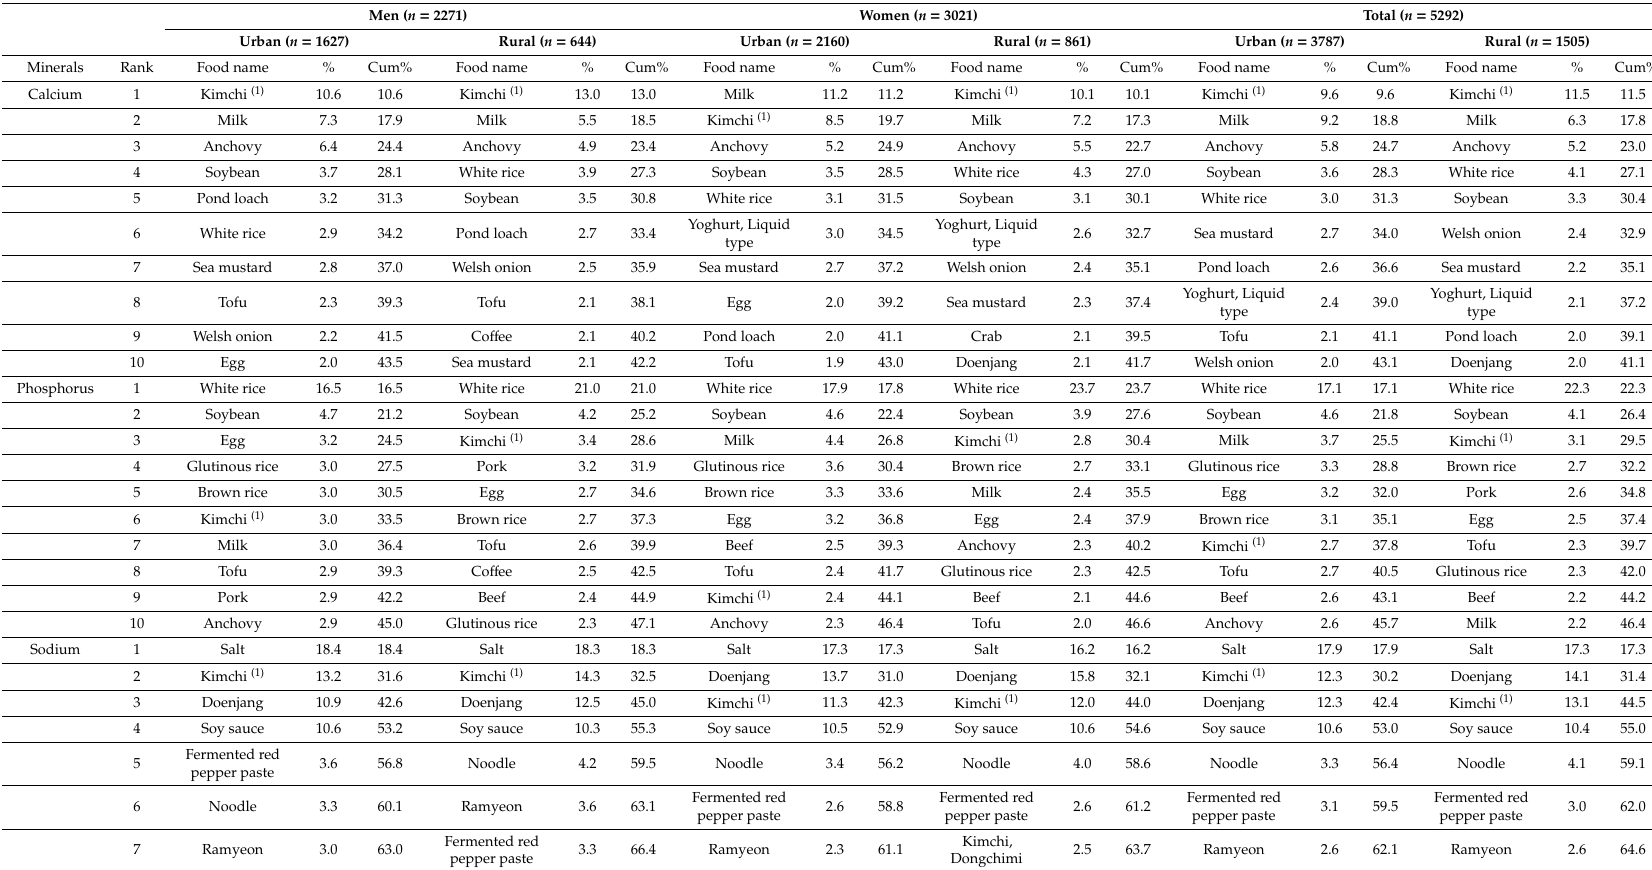
Table 5. Main food sources of minerals of rural and urban Korean